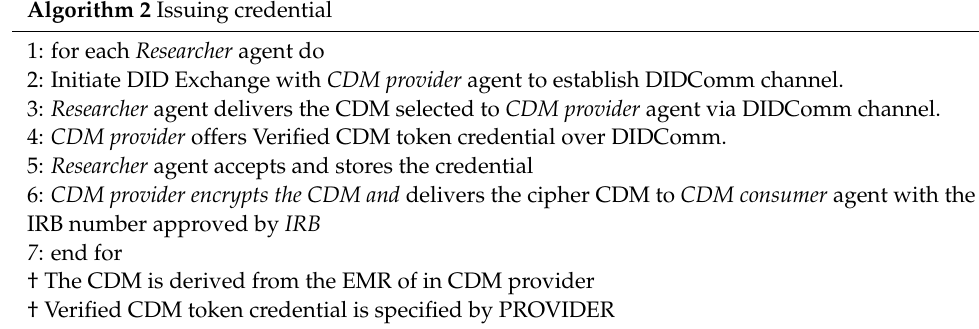
Algorithm 2 Issuing